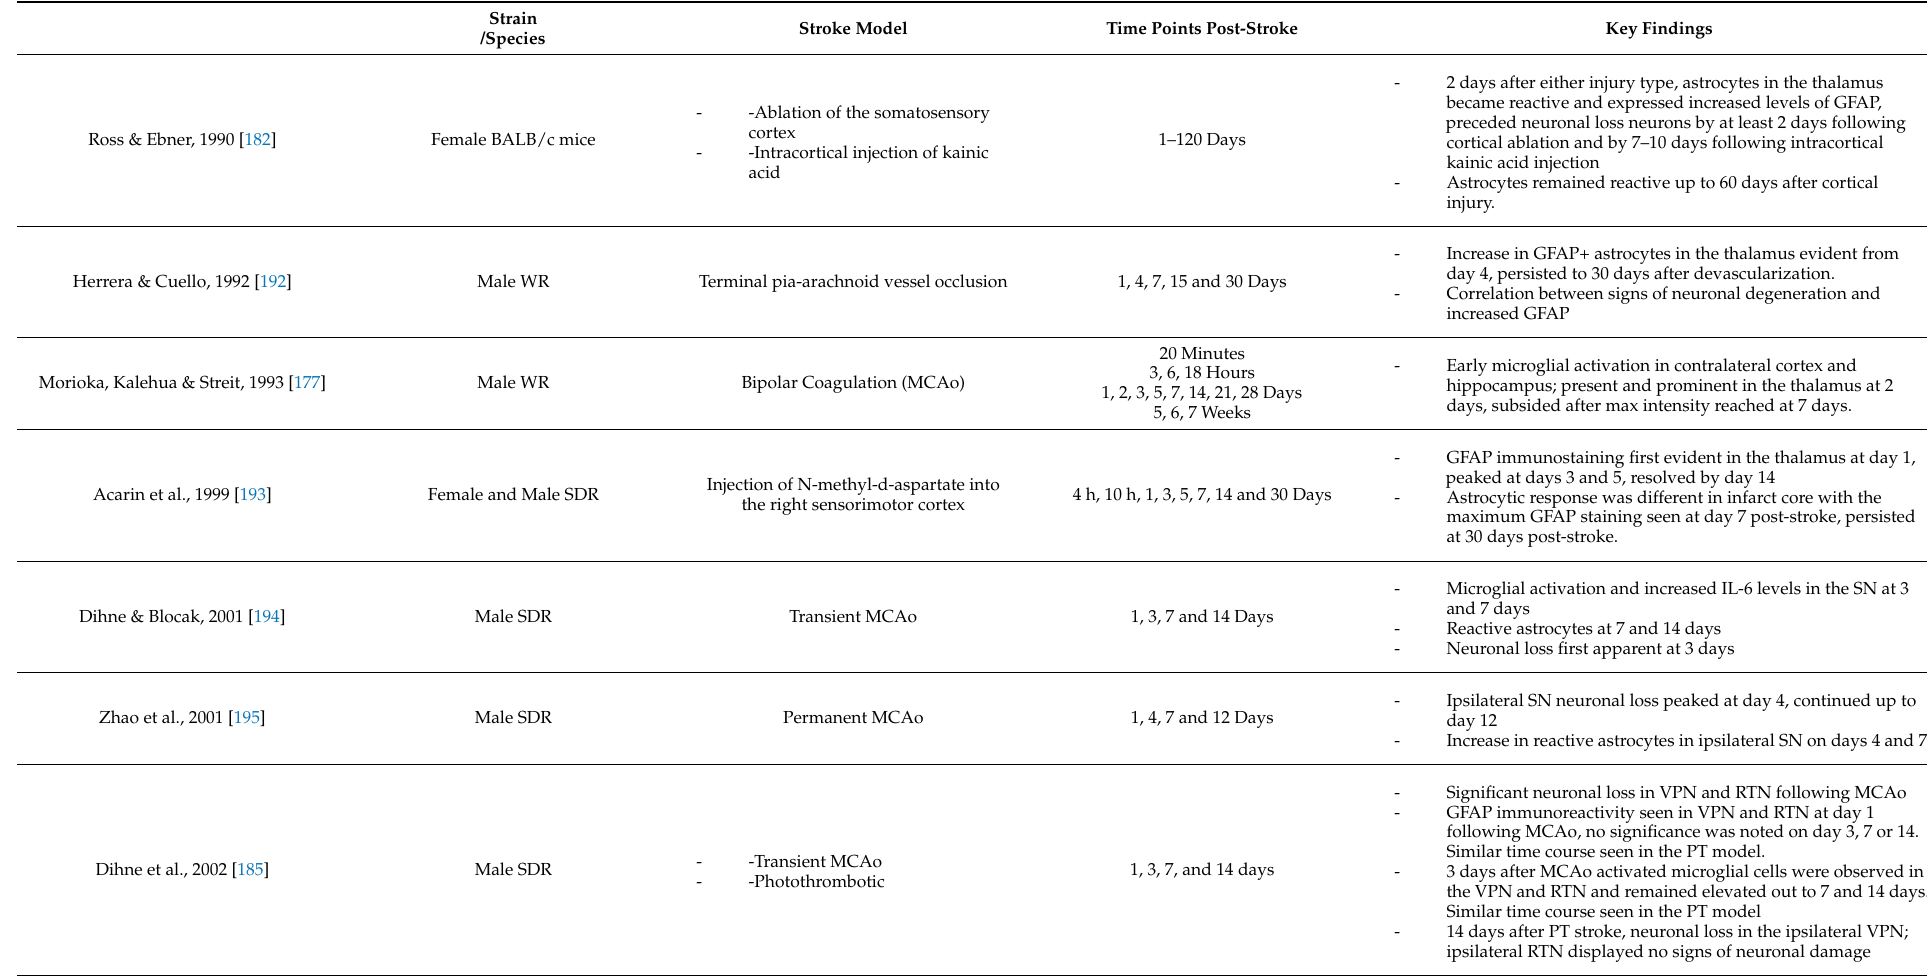
Table 1. Summary of current experimental studies of neuroinflammation in secondary